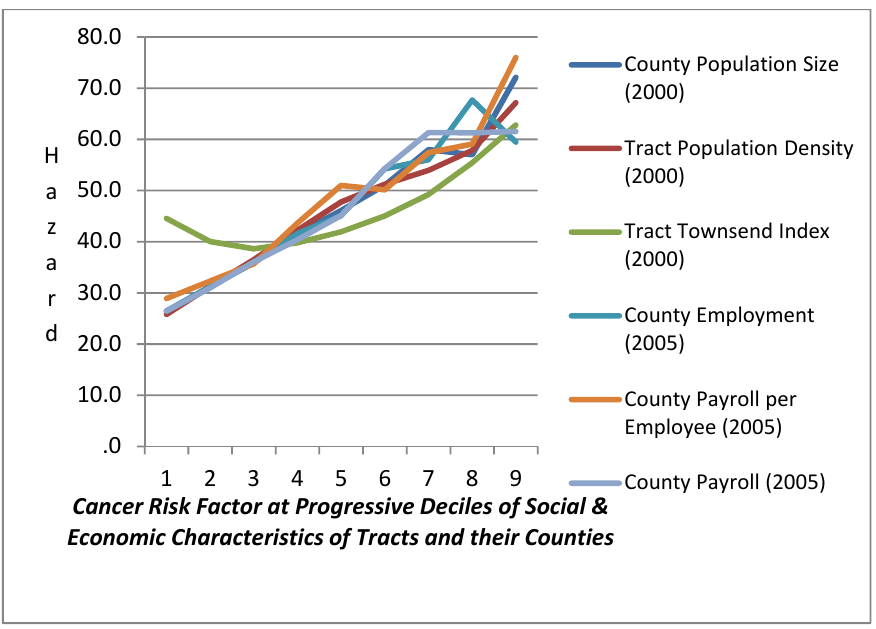
Figure A2. Gradients in HAP Cancer Exposure Risk per MM (2005) at Progressive Deciles of Population Size, Density, Economic Activity, & Socioeconomic